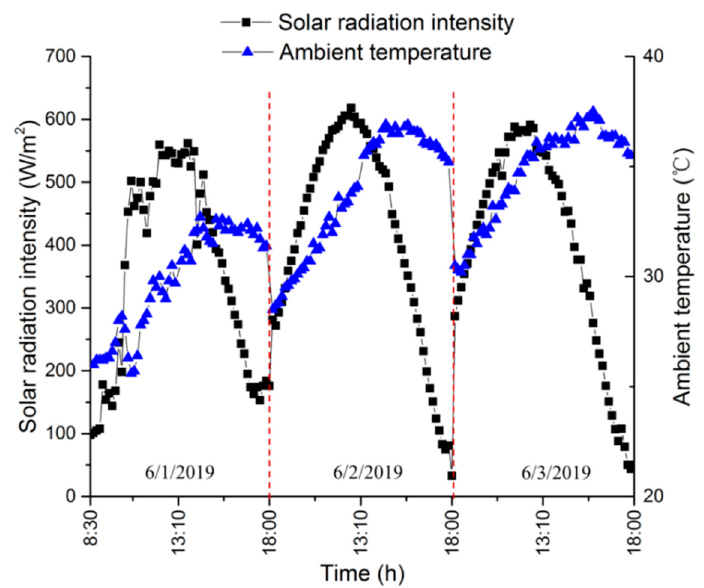
Figure 11. The change of solar radiation intensity and ambient temperature.